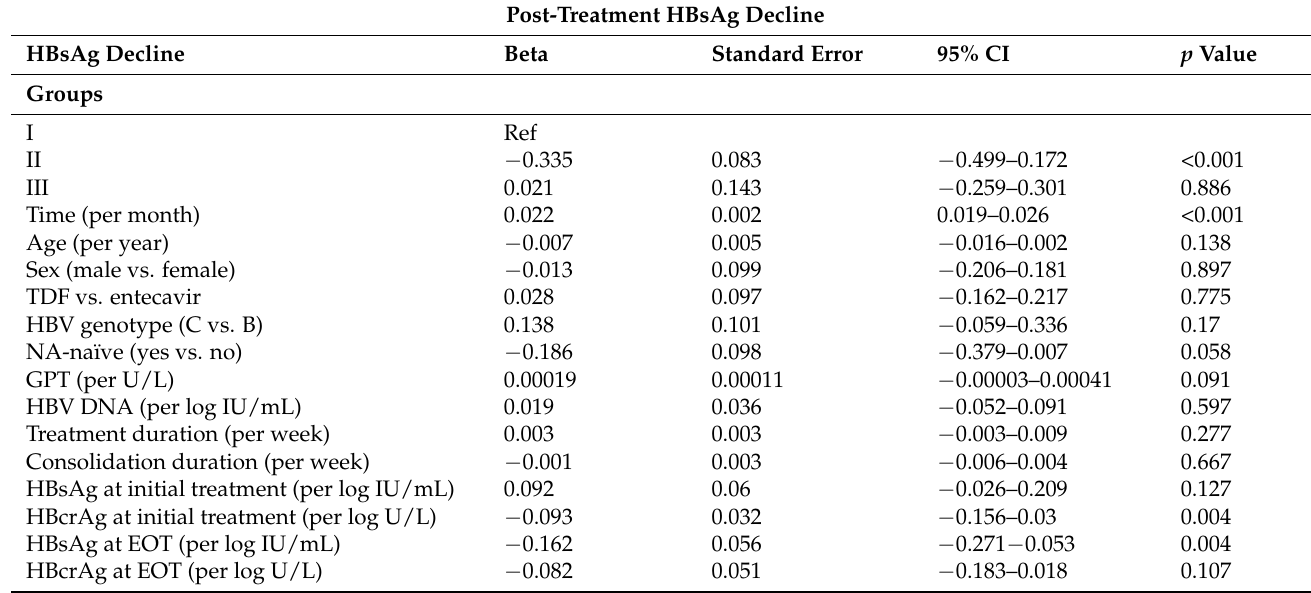
Table 4. Multivariable analysis of HBsAg decline by generalized estimating equations analysis.